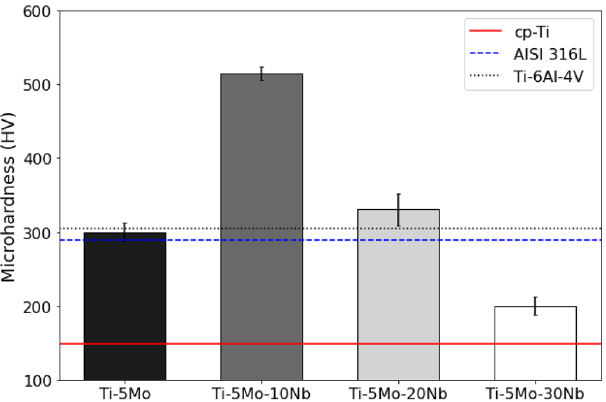
Figure 6. Vickers Microhardness of as-cast Ti-5Mo-xNb system alloys, compared to other metallic biomaterials.